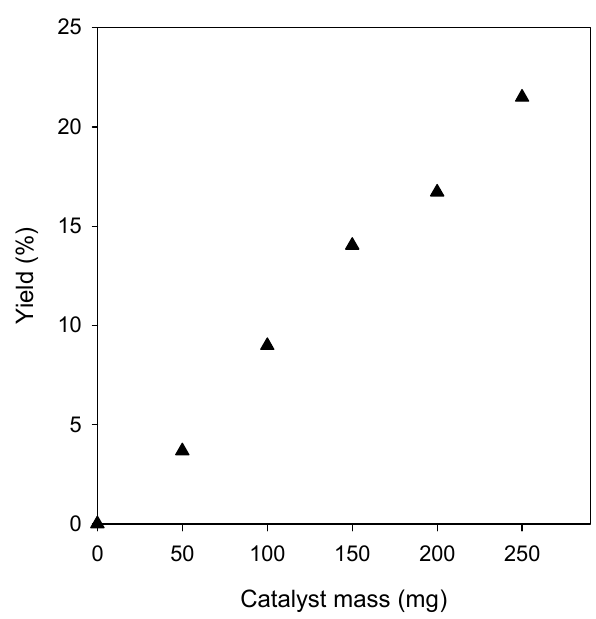
Figure 1. Effect of catalyst loading on the yield of 4-methylcoumarin: reaction time, 20 min; reaction temperature, 100 °C; and phenol/ethyl acetoacetate, molar ratio 1:1.